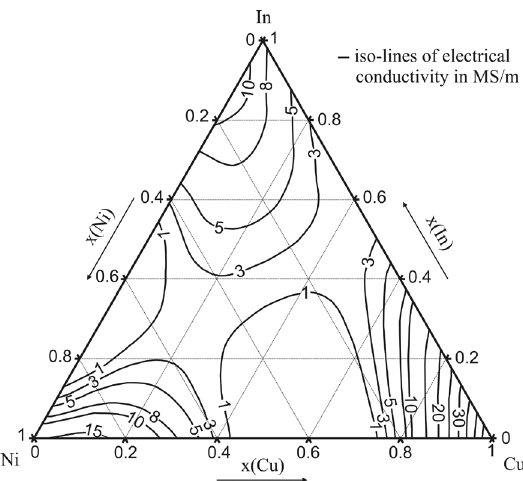
Figure 7. Iso-lines of electrical conductivity of Cu-In-Ni ternary